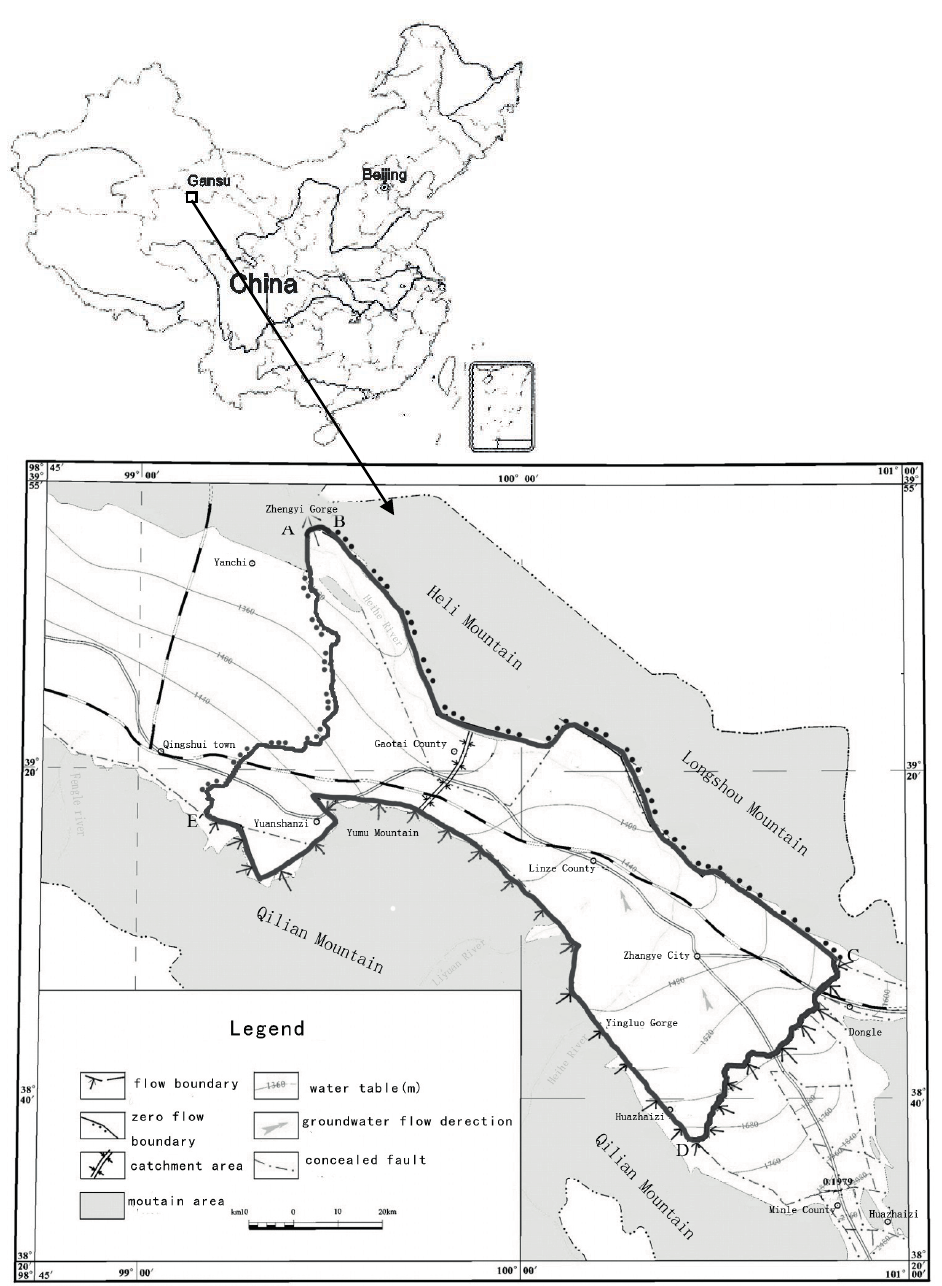
Fig. 2 Hydrogeological model of Zhangye basin and the boundary conditions